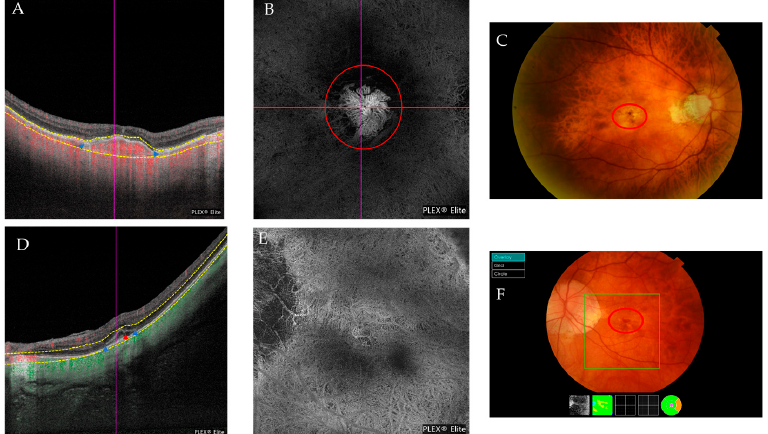
Figure 5. ( A – C ) Multimodal imaging from the same patient with a Fuch’s spot. ( A ) The blue arrowheads indicate the limits of the CNV. ( B ) The outer retina to the choriocapillaris (ORCC) on the OCTA images with a tailing artifact removed from the en-face image. The red circle indicates the CNV. ( C ) The red circle indicates the position of the CNV obtained via retinography. ( D , E ) Multimodal imaging from the same patient presenting with active CNV. ( D ) An OCT scan that shows signs of CNV activity with retinal thickening due to subretinal fluid and small intraretinal cysts (red arrowhead). Its limits are indicated by the blue arrowheads. ( E ) En-face ORCC from an OCTA image of the same patient. ( F ) The red circle indicates the presence of the membrane and blood in this patient’s retinography.